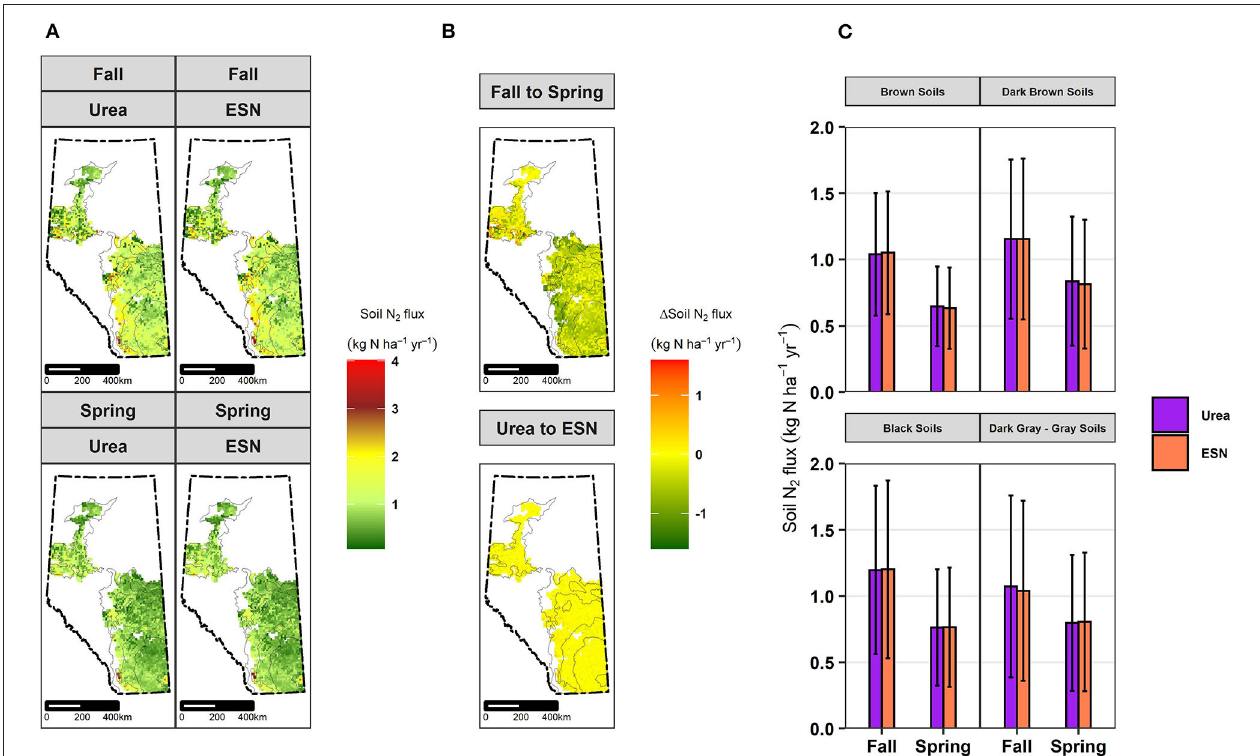
FIGURE 10 | (A) Spatial distribution of modeled annual (January 1–December 31) soil N 2 fluxes averaged over the simulation period (2011–2015) for each township for each of the fall and spring banded urea and ESN applications across mid-slope landforms of Alberta under simulated barley cultivation. Positive fluxes represent emissions and vice versa. (B) Spatial distribution of differences in modeled annual soil N 2 fluxes for fall vs. spring and urea vs. ESN applications averaged over the simulation period (2011–2015) for each township across mid-slope landforms of Alberta under simulated barley cultivation. A positive change represents an increase in N 2 fluxes for a change from fall to spring or from urea to ESN and vice versa. The white areas on the map were not modeled based on the selection criteria as described in section Methodology and Model Inputs. The thick dashed lines on the maps represent Alberta’s provincial boundary and the thin black lines within the maps demarcate soil group areas. (C) Soil group-wise averages of modeled annual soil N 2 fluxes for fall vs. spring banding and urea vs. ESN applications averaged over the simulation period (2011–2015) for all the townships in each soil group area across mid-slope landforms of Alberta under simulated barley cultivation. Error bars represent standard deviations illustrating spatiotemporal variations in modeled annual soil N 2 fluxes within each soil group